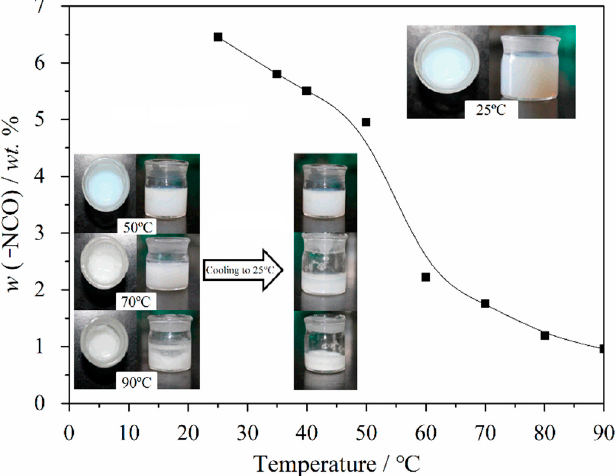
Figure 8. -NCO content in the emulsions suffering from 10 min heat via different temperature and their digital photos.